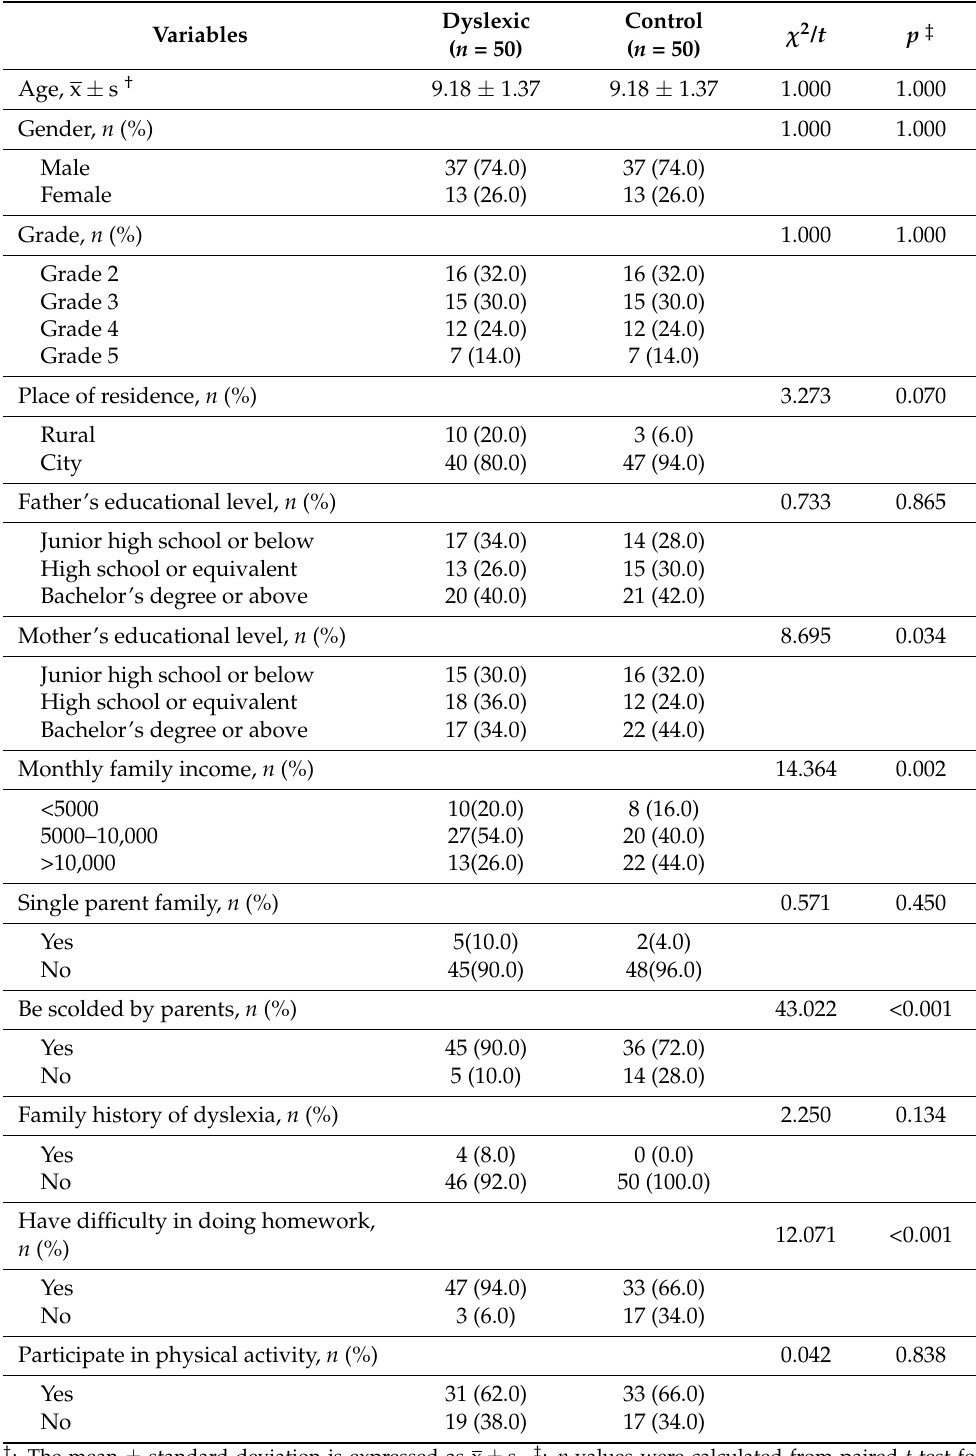
Table 1. General demographic characteristics of the study